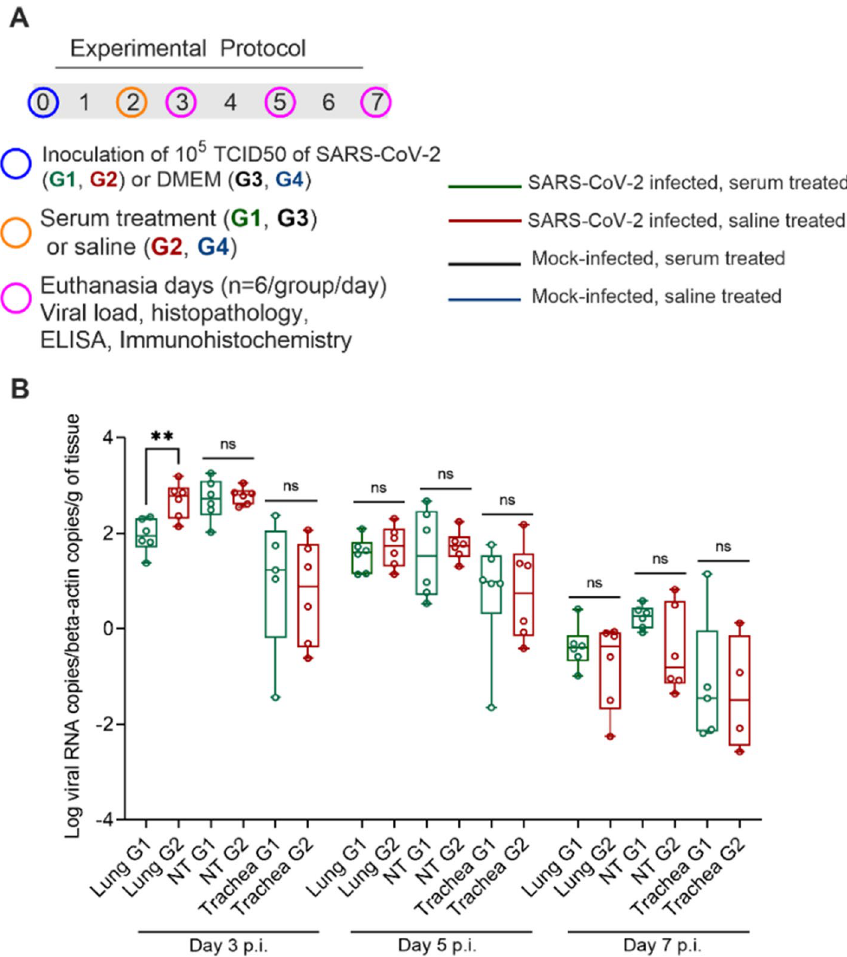
Figure 3. Challenge test in Golden Syrian hamsters. ( A ) Study design—scheme for infecting animals with SARS-CoV-2 followed by treatment with equine anti-SARS-CoV-2 F(ab ′ ) 2 immunoglobulin. ( B ) SARS- CoV-2 RNA copies as measured using RT-qPCR per number of β-actin RNA copies per gram of tissue. Green: G1 animals (n = 6 per subgroup), i.e., serum-treated, SARS-CoV-2-infected animals; red: G2 animals (n = 6 per subgroup), i.e., nontreated, SARS-CoV-2-infected animals. p.i. = post infection; n.s.: not significant (p value > 0.05); **p value = 0.0043 (Day 3